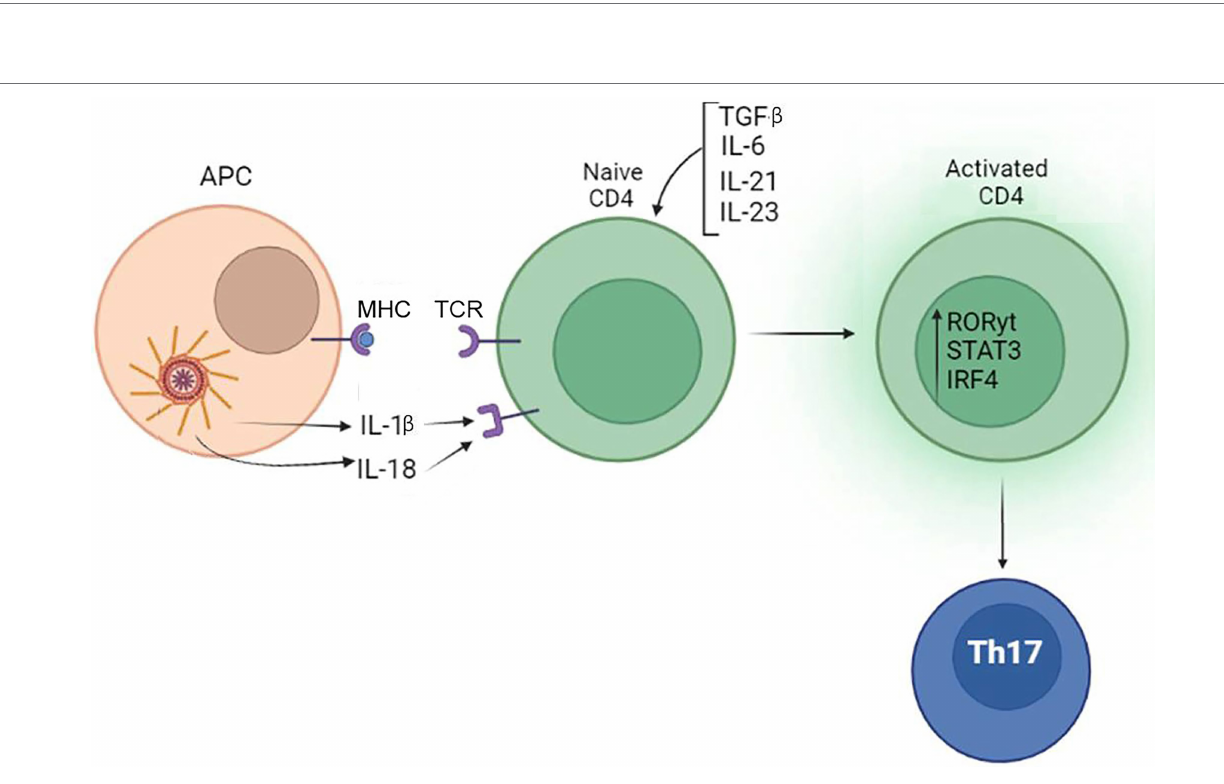
FIGURE 5 | Inflammasome contribute to differentiation of Th17. IL-1 β produced by the inflammasome, when combined with TGF- β , IL-6, IL-21, and IL-23 produced by tissue cells, can promote the differentiation of Th17